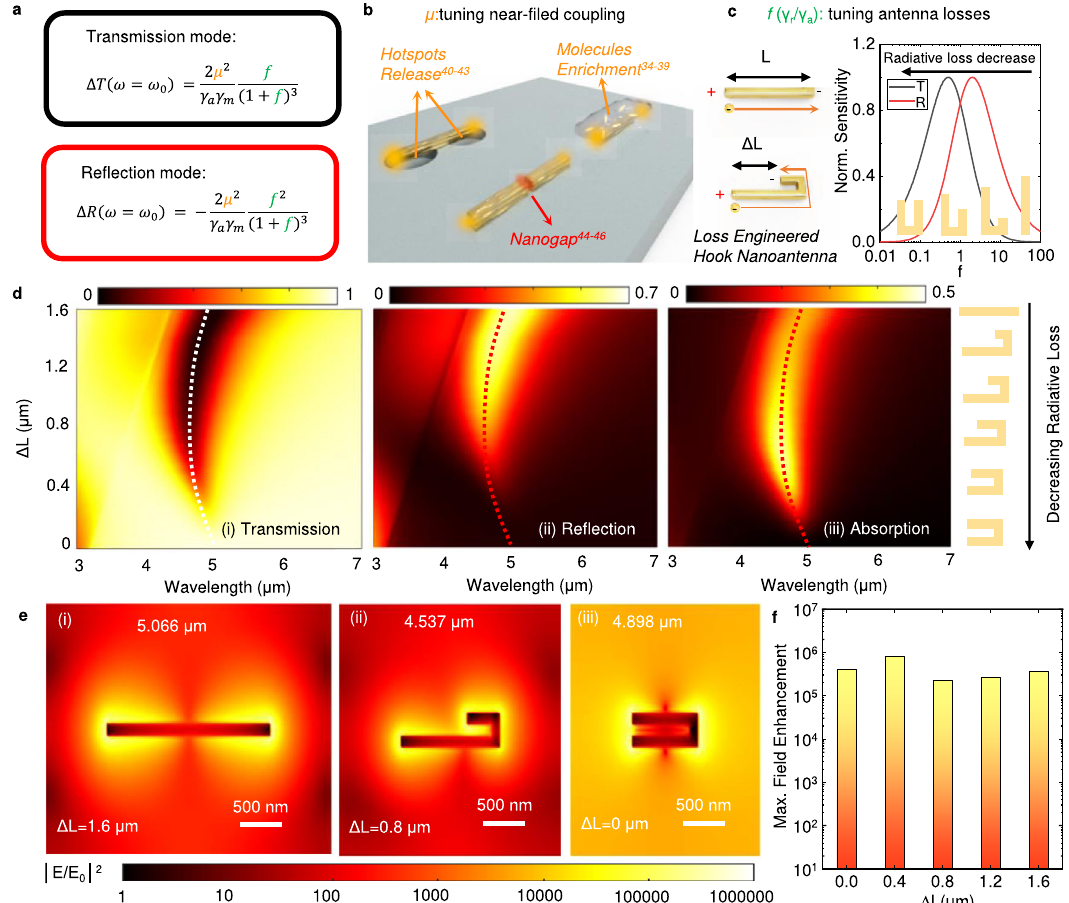
Fig. 2 Design principle of hook nanoantenna. a The derived intensity changes in transmission and re fl ection mode with the perfect match of molecular absorption and antenna resonance by TCMT. b The summary of methods affecting the coupling strength between molecules and antenna by previous works. c The proposed hook antenna for sensing optimization by tuning the radiative loss and the effect of loss ratio to intensity change in transmission and re fl ection mode. d The simulated far- fi eld spectra in transmission (i), re fl ection (ii), and absorption(iii) of hook antenna by changing the Δ L, indicating the tuning of radiative loss. e The electric fi eld enhancement distribution of hook nanoantenna devices at resonance wavelength with different Δ L of 1.6 μ m (i), 0.8 μ m (ii) and 0 μ m (iii). ( f ) The extracted maximum electric fi eld enhancement of hook nanoantenna devices with different Δ